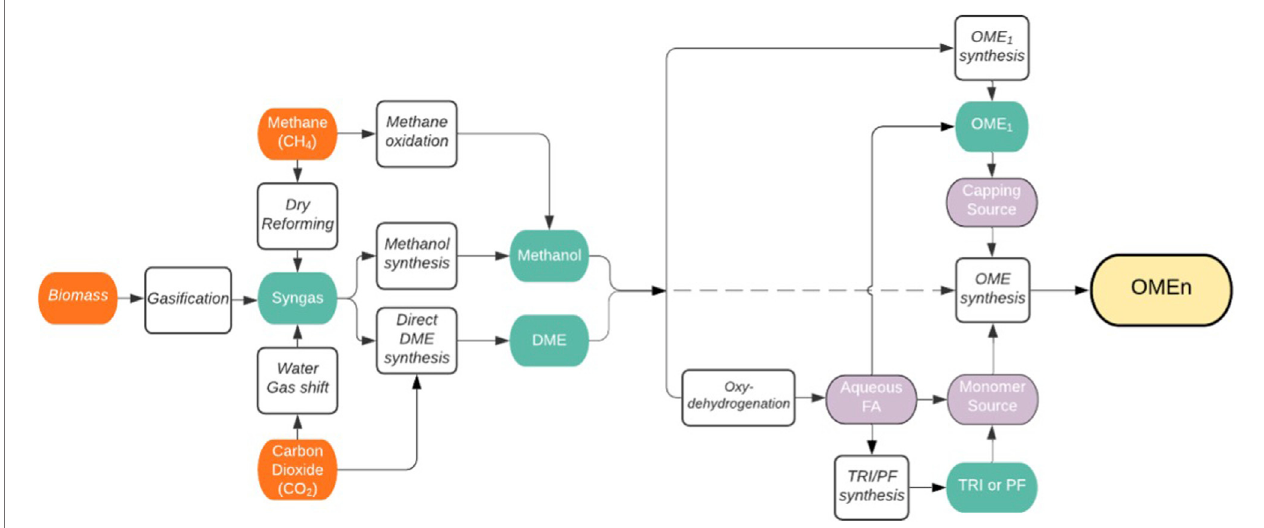
FIGURE 5 | Liquid phase synthesis of polyoxymethylene dimethyl ethers (OME) via methanol (derived from various sources) and DME. The depicted routes and reactantshavebeenreportedtobeusedfortheproductionofOME n withn > 1:OME 1 (cid:2) dimethoxymethane,TRI (cid:2) trioxane,PF (cid:2) paraformaldehyde,FA (cid:2) formaldehyde, DME (cid:2) dimethyl ether.